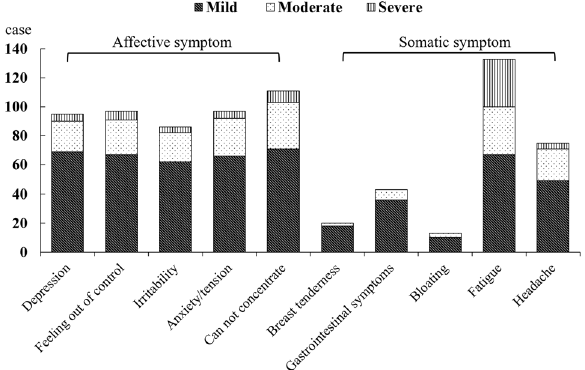
Figure 3. Distribution of PMS symptoms in female students of senior high school.